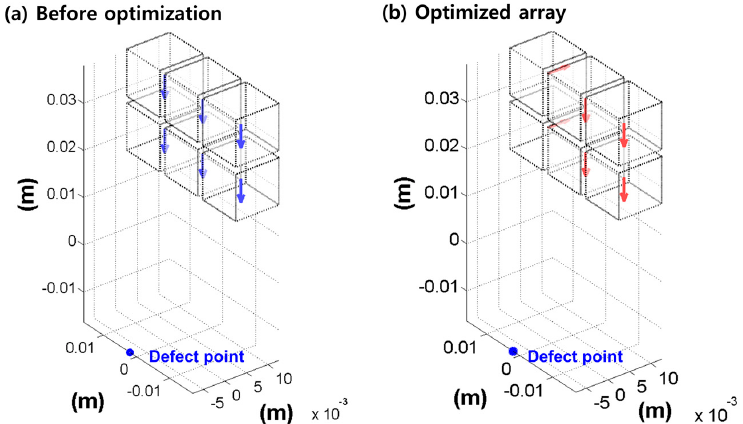
Figure 5. Resulting configuration of the Halbach array optimized for the given animal subject condition. ( a ) Initial configuration and ( b ) optimized configuration with different magnetic directions.